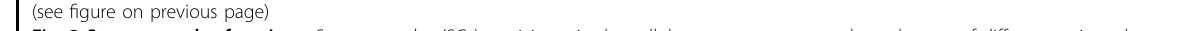
Fig. 3 Stress granules functions. Stress granules (SGs) participate in the cellular response to stress through a set of different actions that are interconnected and derive from the individual activities of SG components and from the assembly/disassembly of these foci. A SG formation involves the disassembly of translation initiation complexes and the coalescence of mRNAs molecules, ribosomal subunits and many proteins involved in translation, resulting in translational arrest and protein synthesis suppression. Additionally, several SG components are known to act as translational repressors. B SGs function as stores of RNAs and proteins in cells under stress, but allow rapid mobilization of these molecules when the damaging conditions subside. C SGs may modulate the expression of speci fi c proteins during stress, by directing particular mRNA species to different possible fates. This action appears to involve an exchange of mRNAs between SGs and processing bodies, upon docking of these two types of RNA granules. Translation of some proteins involved in stress responses may be prioritized, some mRNAs may be kept stored in SGs or elsewhere, while others, such as those codifying proteins prone to misfolding, may be targeted for degradation by the processing bodies. D By intercepting particular signalling molecules, SGs may trigger signalling cascades that regulate or modify cell growth, survival or metabolism, or which promote apoptosis. E SGs play a role in the cellular response against viral infection, by sequestering the endogenous translational machinery necessary for viral protein expression and by activating proteins involved in antiviral